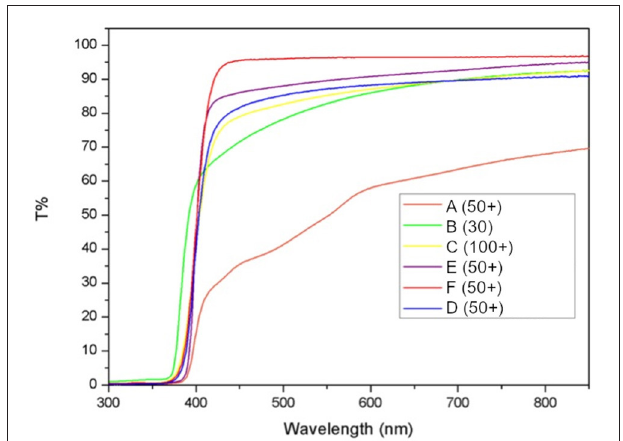
FIGURE 1 | Absorbance (A) spectrum of protoporphyrin IX measured in the range 300–700nm.